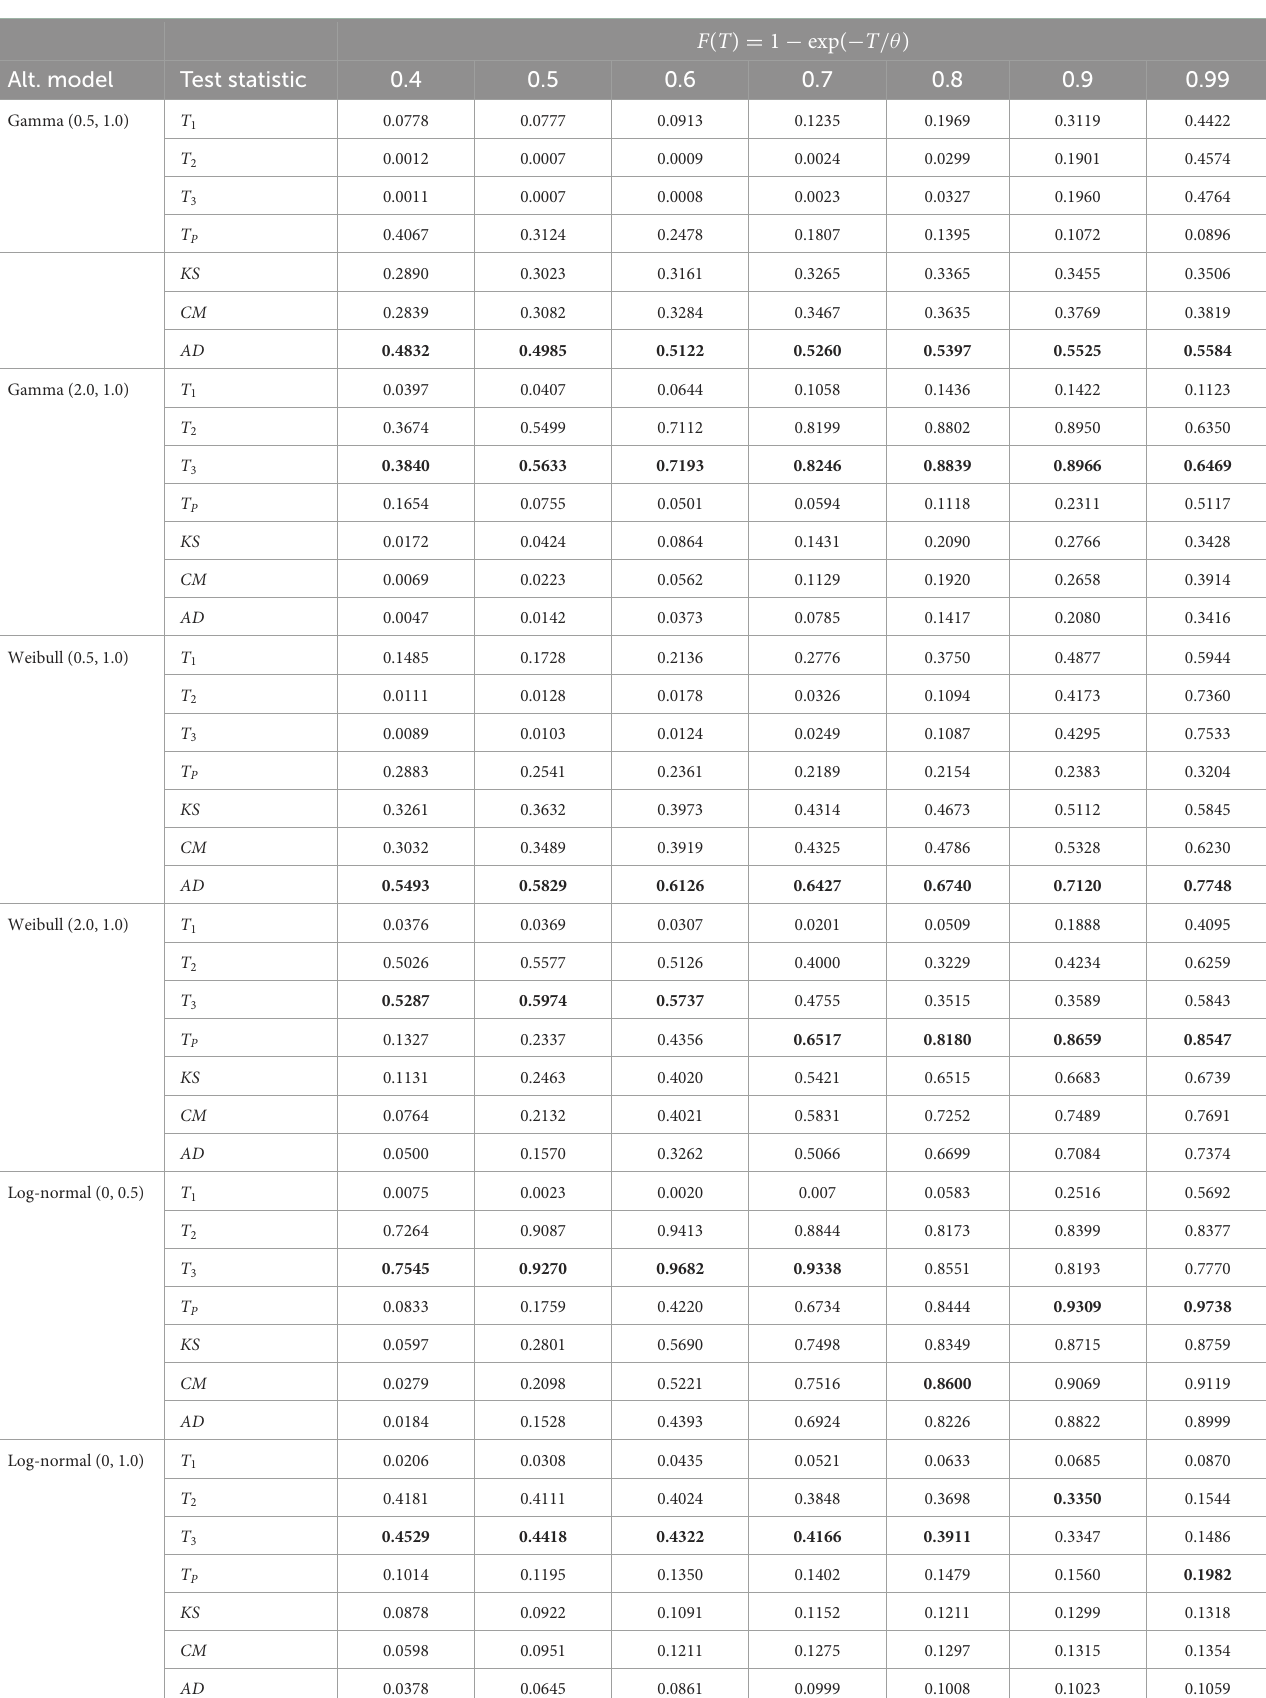
TABLE 3 Empirical power for various alternative models, n